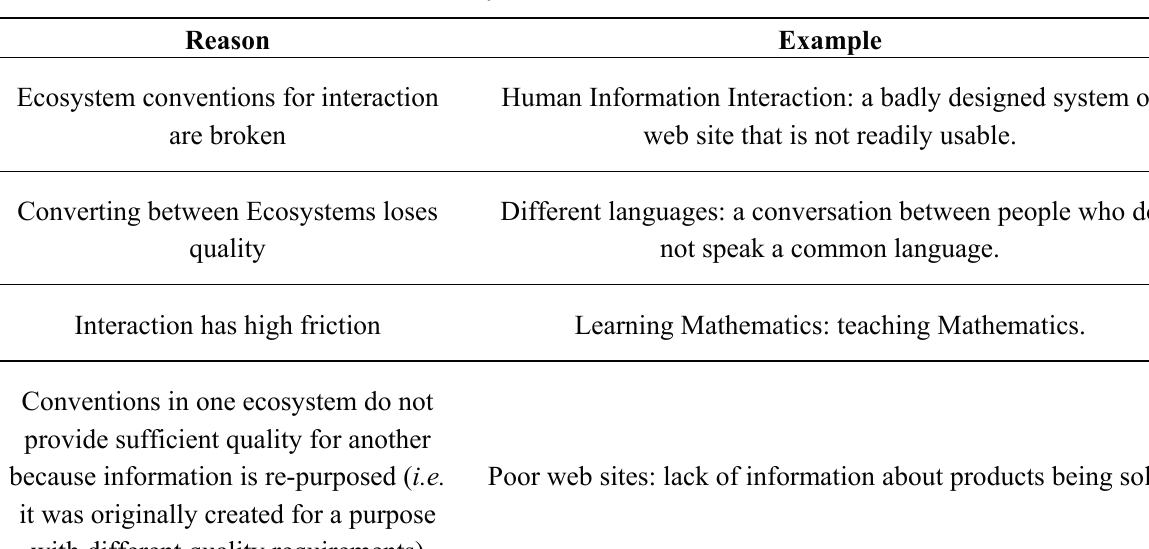
Table 3. Ecosystem Interface Failure